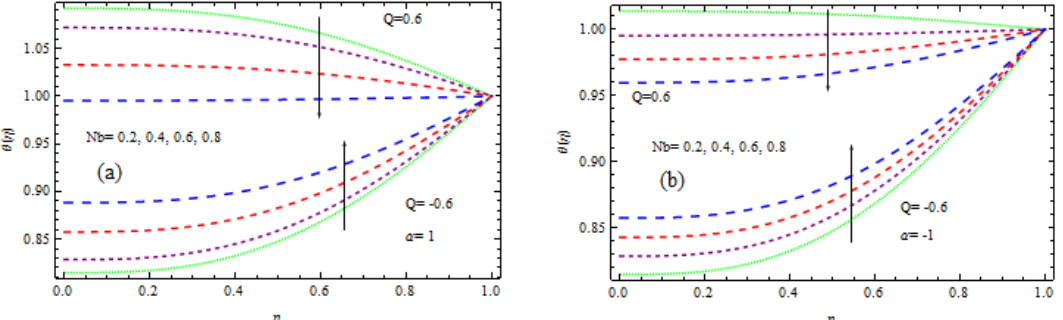
Figure 8. ( a , b ) Influence of Brownian factor on temperature.